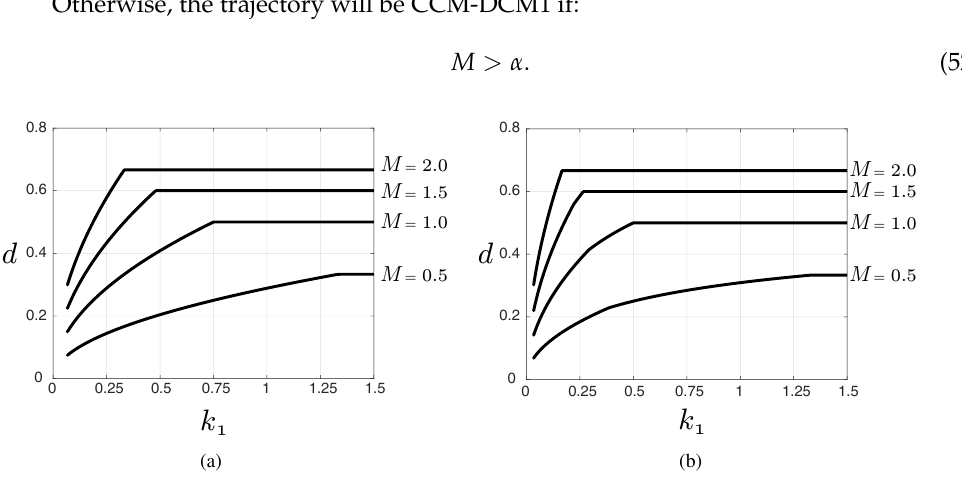
Figure 9. Families of closed-loop characteristic curves with a constant conversion ratio: ( a ) case α = 1 and ( b ) case α =